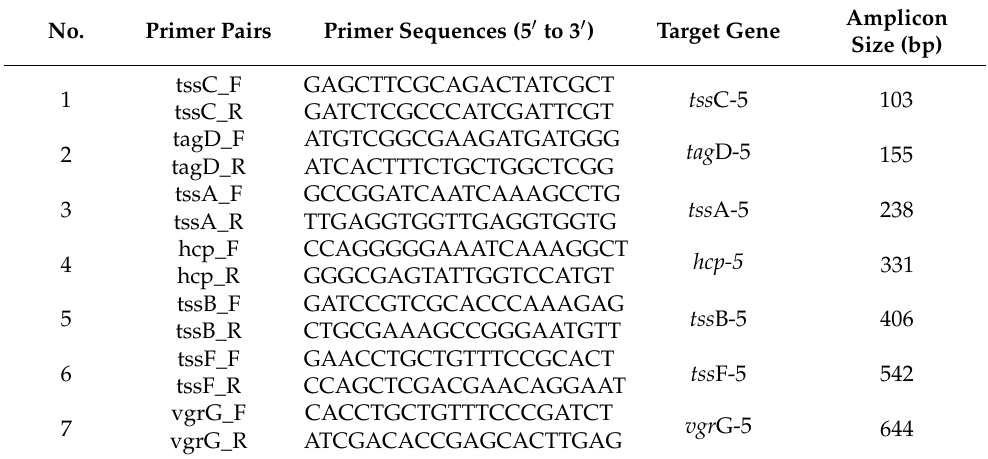
Table 1. Primers used for the optimization of the multiplex PCR